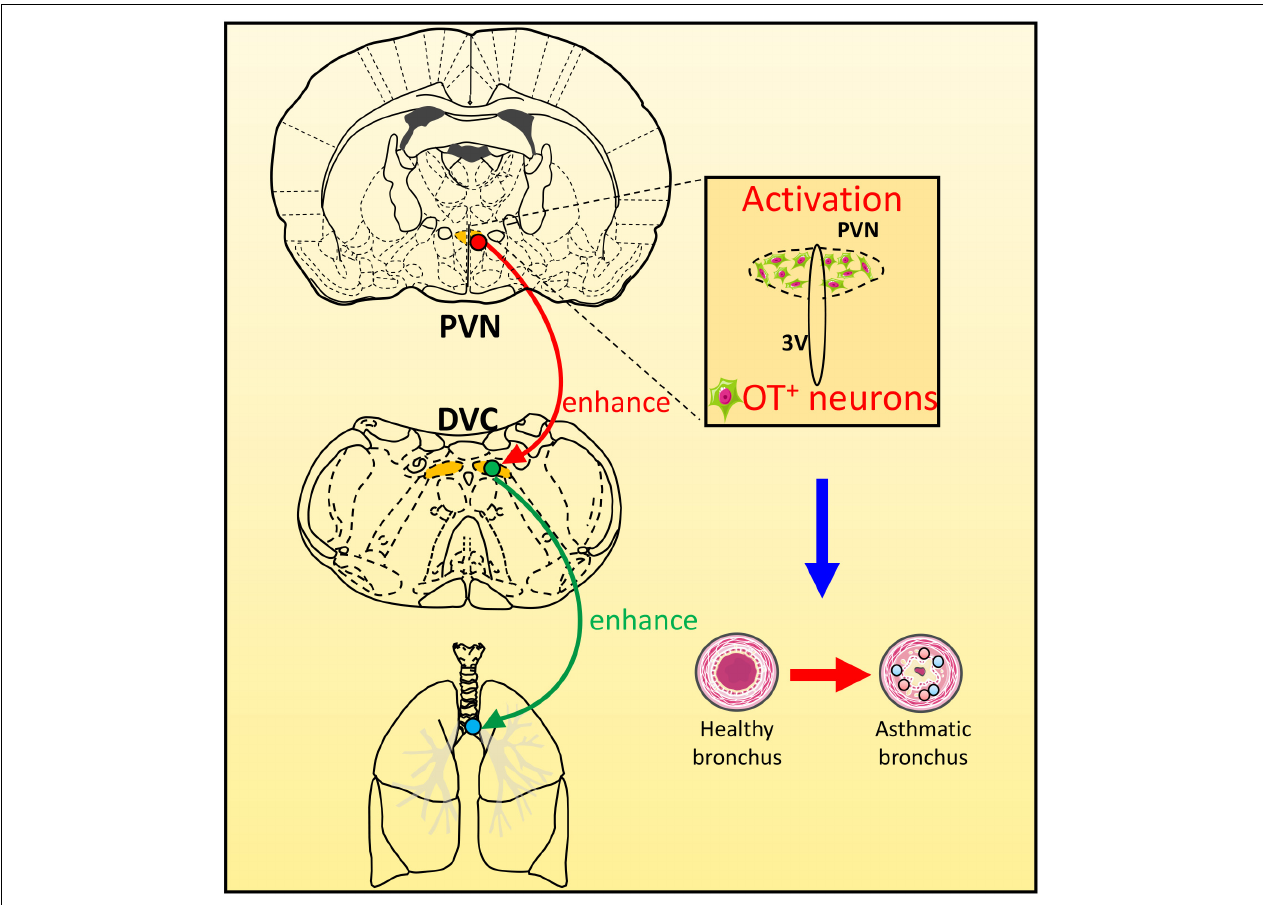
FIGURE 6 | The scheme of the possible role of PVN-DVC circuit on modulating respiratory response during an asthma attack. During asthma attack, neurons in PVN and DVC were activated, and OT expressions in PVN were increased. The OT neurons in PVN may project to DVC to regulate the asthma attack.